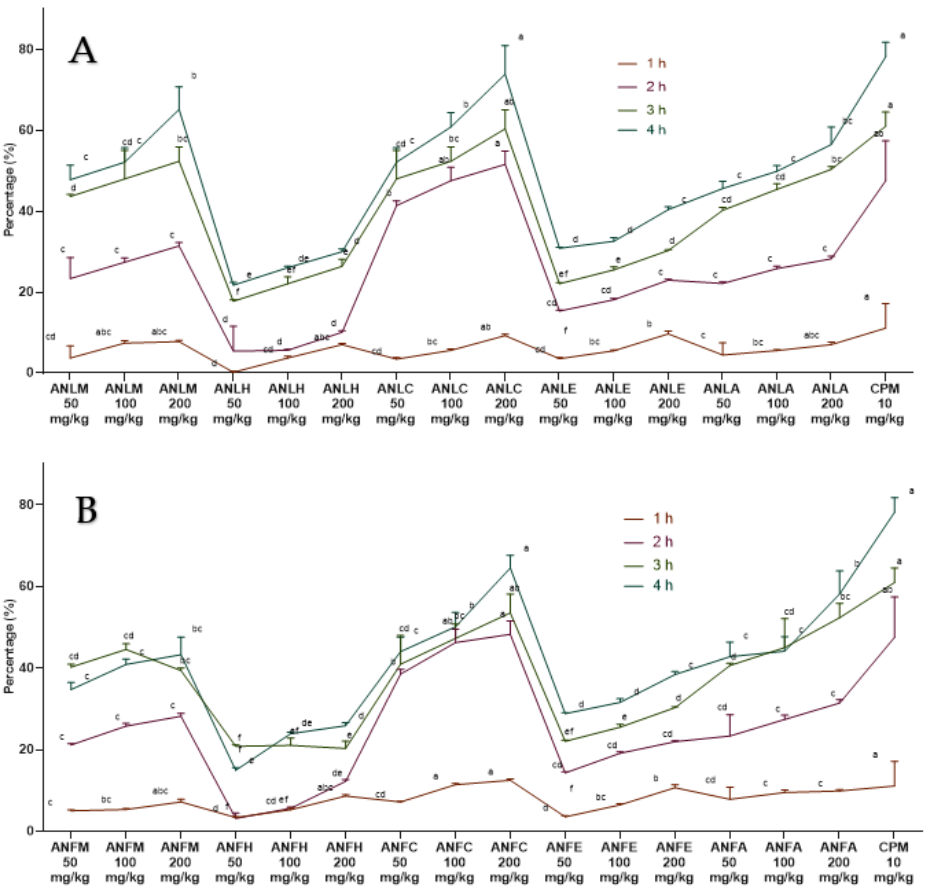
Figure 3. Percentage inhibition of A. nitida on histamine induced paw edema in rats ( A ) A . nitida leaves methanolic extract (ANLM), A . nitida leaves n-hexane fraction (ANLH), A . nitida leaves chloroform fraction (ANLC), A . nitida leaves ethyl acetate fraction (ANLE), A . nitida leaves aqueous fraction (ANLA), and ( B ) A . nitida fruit methanolic extract (ANFM), A . nitida fruit n-hexane fraction (ANFH), A . nitida fruit chloroform fraction (ANFC), A . nitida fruit ethyl acetate fraction (ANFE), A . nitida fruit aqueous fraction (ANFA). CPM: chlorpheniramine maleate. Data were analyzed using seven replicates as mean ± SD by two-way ANOVA followed by Bonferroni’s test. Different letters represent the significance level of p < 0.05 with respect to all other samples “a” with reference to positive control, “b” with reference to methanolic extract and “c, d, e, f” with reference to n-hexane, chloroform, ethyl acetate and aqueous fraction, respectively.